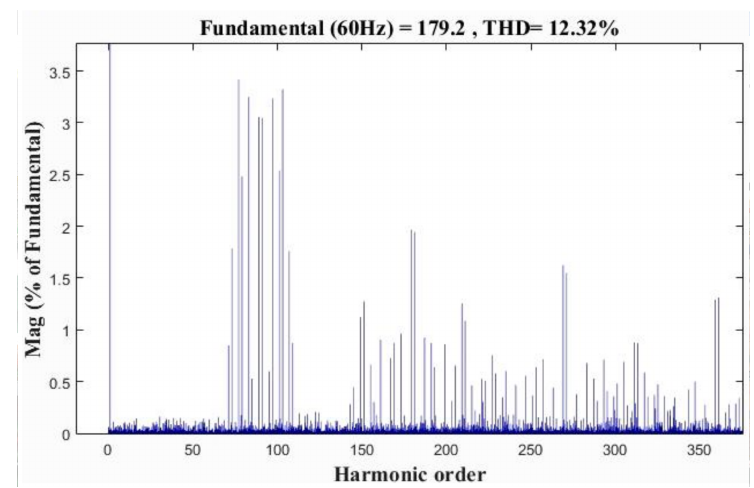
Figure 8. THD spectrum of output voltage (Vab) of THI-PWM.